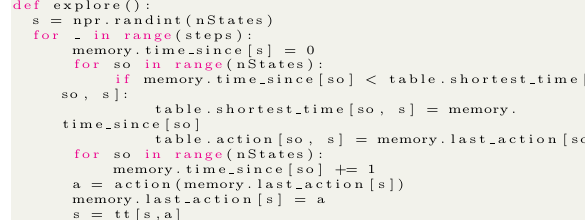
table . shortest time [ so , s ] = memory. time since [ so ] 8 table . action [ so , s ] = memory. last action [ so ]